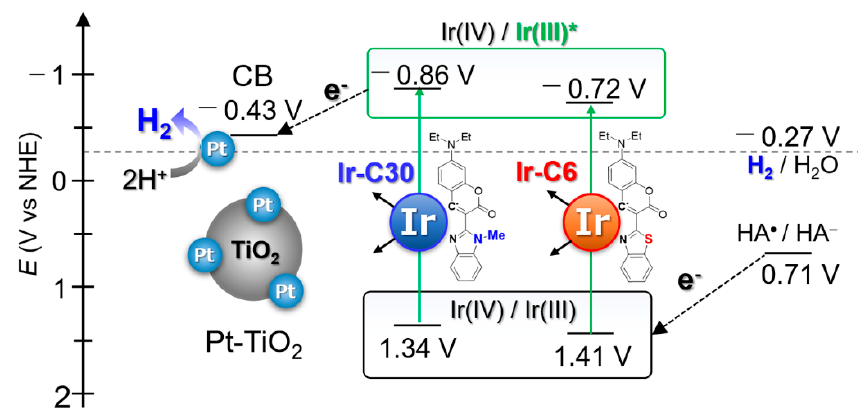
Figure 7. Schematic energy diagram showing the plausible mechanism of photocatalytic H 2 evolution reaction of Ir-CX@Pt-TiO 2 nanoparticles. The redox potential of one-proton released ascorbate anion (HA - ) and the position of conduction band (CB) minimum of TiO 2 were inferred from the literatures [56,57].